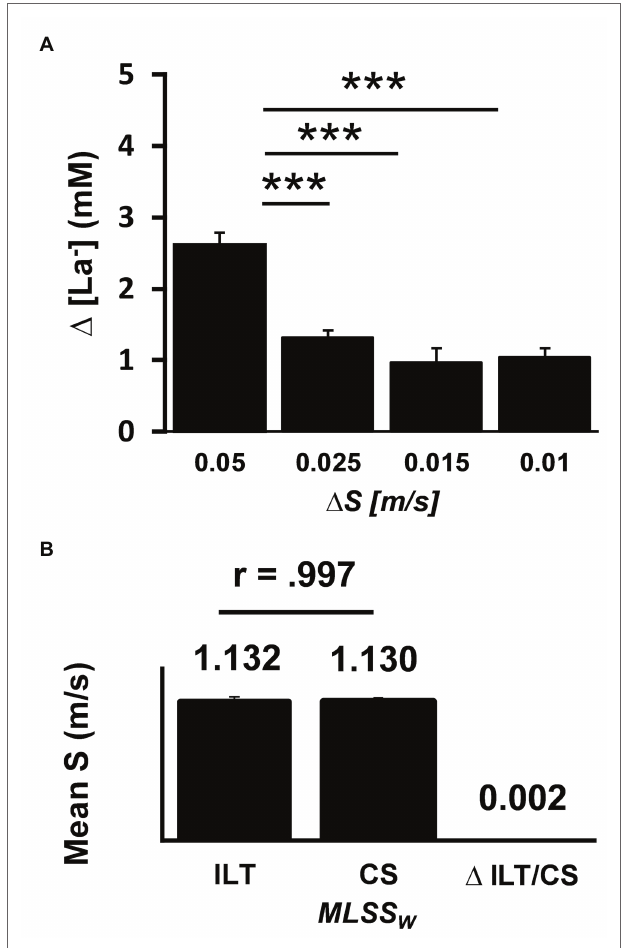
FIGURE 6 | Lactate dynamics at the individual lactate threshold (ILT). (A) Relationship between workload (WL) variation ( ∆ S) and blood lactate dynamics ( ∆ [La − ]) at the ILT using threshold criterion 1 and 2 (TC1/2). A rapid blood lactate accumulation (>0.4 Mm) occurs in response to a minute WL increase (0.01 m/s) after 1–6 steps at constant speed. While increments of 0.015 m/s and 0.025 m/s do not differ from 0.01 m/s, a step of 0.05 m/s provokes another significant lactate accumulation (0.05 m/s vs. 0.025 m/s; 0.05 m/s vs. 0.015 m/s, 0.05 m/s vs. 0.01 m/s, N = 65, *** p < 0.001, two- tailed unpaired t -tests). (B) Reliability and validity of the ILT-test. Intraindividual day to day comparison of the maximal lactate steady state workload (MLSS W ) obtained by an ILT-test and a subsequent constant speed (CS)-test (ILT- test = 1.132 m/s, CS-test = 1.130 m/s, ∆ ILT-test/CS-test = 0.002 m/s, CV = 0.49%, n = 13, r = 0.997, p < 0.001). Data are mean ± SE. [La − ], arterial lactate concentration; S,